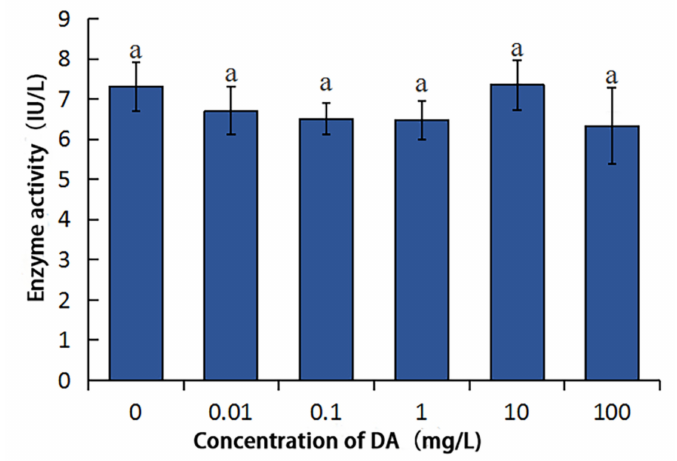
Figure 6. Effect of DA on the enzymatic activity of BmPDIA5. Using the DMRT to analyze, the same lower case letters in the figure indicate there were no significant differences between groups ( p < 0.05).